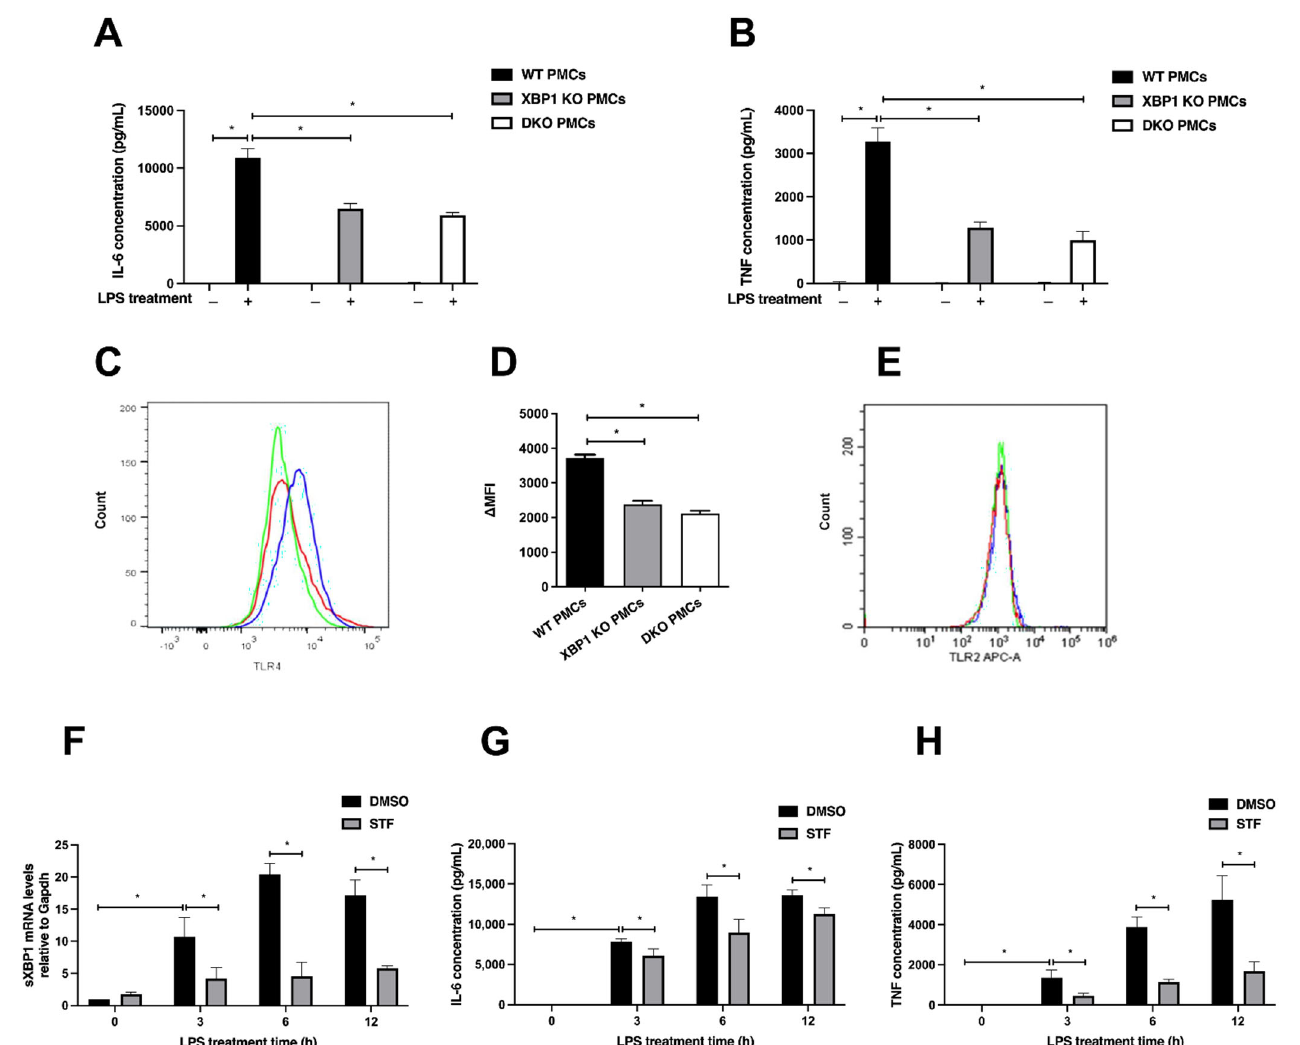
Figure 5. TLR4 surface expression and function is supported by the IRE1/XBP1 pathway. TNF and IL ‐ 6 levels in the supernatants in response to LPS stimulation (1 μ g/mL, 4 h) were measured by ELISA for an equal number of YFP ‐ sorted XBP1 KO and DKO PMCs, as compared to WT PMCs. The average of three independent experiments ± SD is shown for ( A ) IL ‐ 6 and ( B ) TNF. * p < 0.05. ( C ) Flow cytometry analysis of TLR4 cell surface expression of XBP1 KO (green histogram) and DKO PMCs (red histogram), as compared to WT PMCs (blue histogram). ( D ) Quantification of TLR4 expression levels in WT, XBP1 KO, and DKO PMCs. Data are presented as the average ± SD of the mean fluorescence intensity minus the background ( Δ MFI) of three independent analyses. * p < 0.05. ( E ) Flow cytometry analysis of TLR2 expression in WT, XBP1 KO, and DKO PMCs (blue, green, and red histograms, respectively). ( F ) RT ‐ qPCR analysis of sXBP1 in PMCs treated with DMSO or 60 μ M STF, 1 h prior to stimulation with LPS (1 μ g/mL) for 3, 6, and 12 h. Bars are represented as the mean of the relative mRNA levels normalized to GAPDH ± SD of three independent experiments. Cytokines levels in the supernatants for ( G ) IL ‐ 6 and ( H ) TNF were determined by ELISA. Each bar represents the mean ± SD of three independent experiments. * p < 0.05.